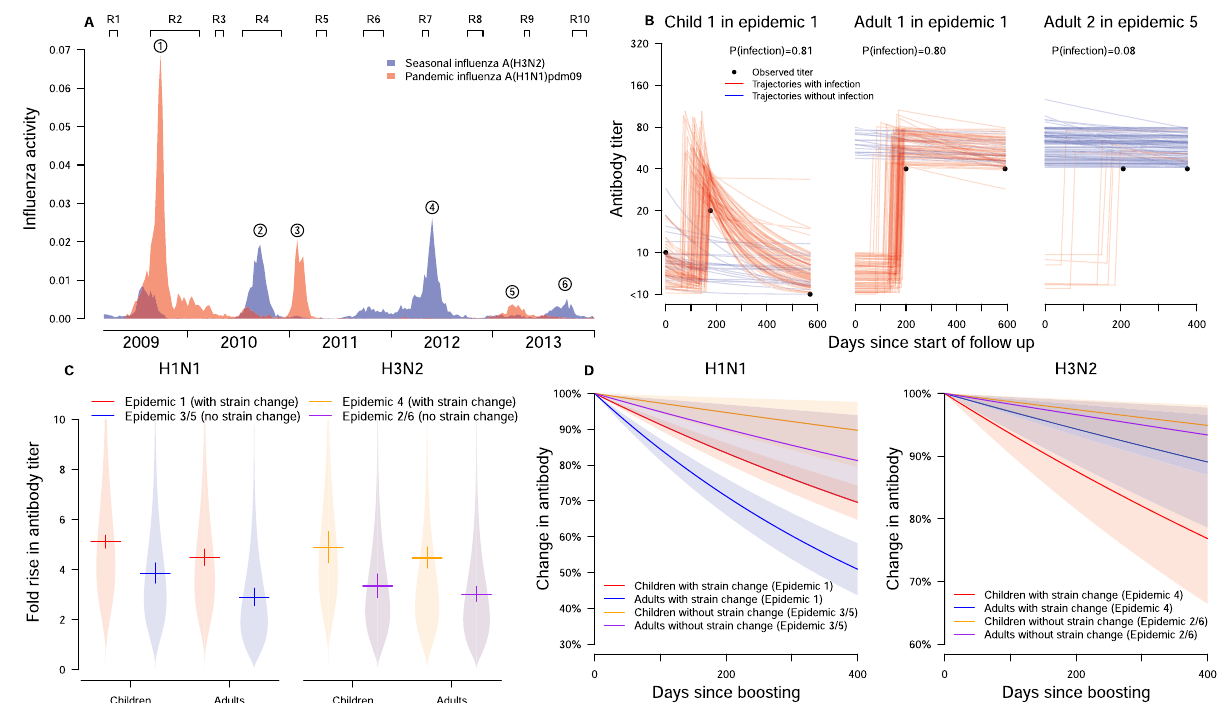
Fig. 1 Estimation of individual HAI titer trajectories. A Timelines of our study, rounds of blood sample collection, and local in fl uenza activity by surveillance data. In fl uenza activity for a strain is computed by weekly proportion of outpatients with in fl uenza-like illness multiplied by the weekly proportion of laboratory specimens testing positive for that strain. R1 to R10 indicates the timing of round 1 – 10 of blood collection. B Illustration of HAI titer trajectories, infection status, infection time and pre-epidemic HAI titer if missing in three example individuals. The black dot represents the observed HAI titer, the curve indicates the augmented HAI titer trajectories since the start of an epidemic, red and blue indicate infection and non-infection respectively. Child 1 with 2-fold rise is imputed to be infected in some augmented data to re fl ect the uncertainty. Adult 1 and 2 with missing pre-epidemic HAI titer, the mid- and post-epidemic HAI titer 3 in log 2 scale, are from epidemic 1 and 5, respectively. Adult 1 and 2 is estimated to be infected with probability 0.80 and 0.08, respectively. It is because (1) the pre-epidemic titer distribution suggested that adult 3 has a higher pre-epidemic titer than adult 2 (probability of <10 was 0.98 and 0.59 in epidemic 1 and 5, respectively), (2) the infection probability for adults for epidemic 1 (18%) was higher than epidemic 5 (2%). C Estimated boosting distribution in HAI titer after infection by subtype. Funnel plots are used to show the distribution. Solid horizontal and vertical lines are used to show the mean and corresponding 95% credible intervals of the estimates based on our estimation approach fi tted to data with 2353 individuals. D The waning after boosting in HAI titer from infection by subtype. The solid lines are used to show the mean waning of HAI titer trajectories over time and the shadowed areas are used to show the corresponding 95% credible